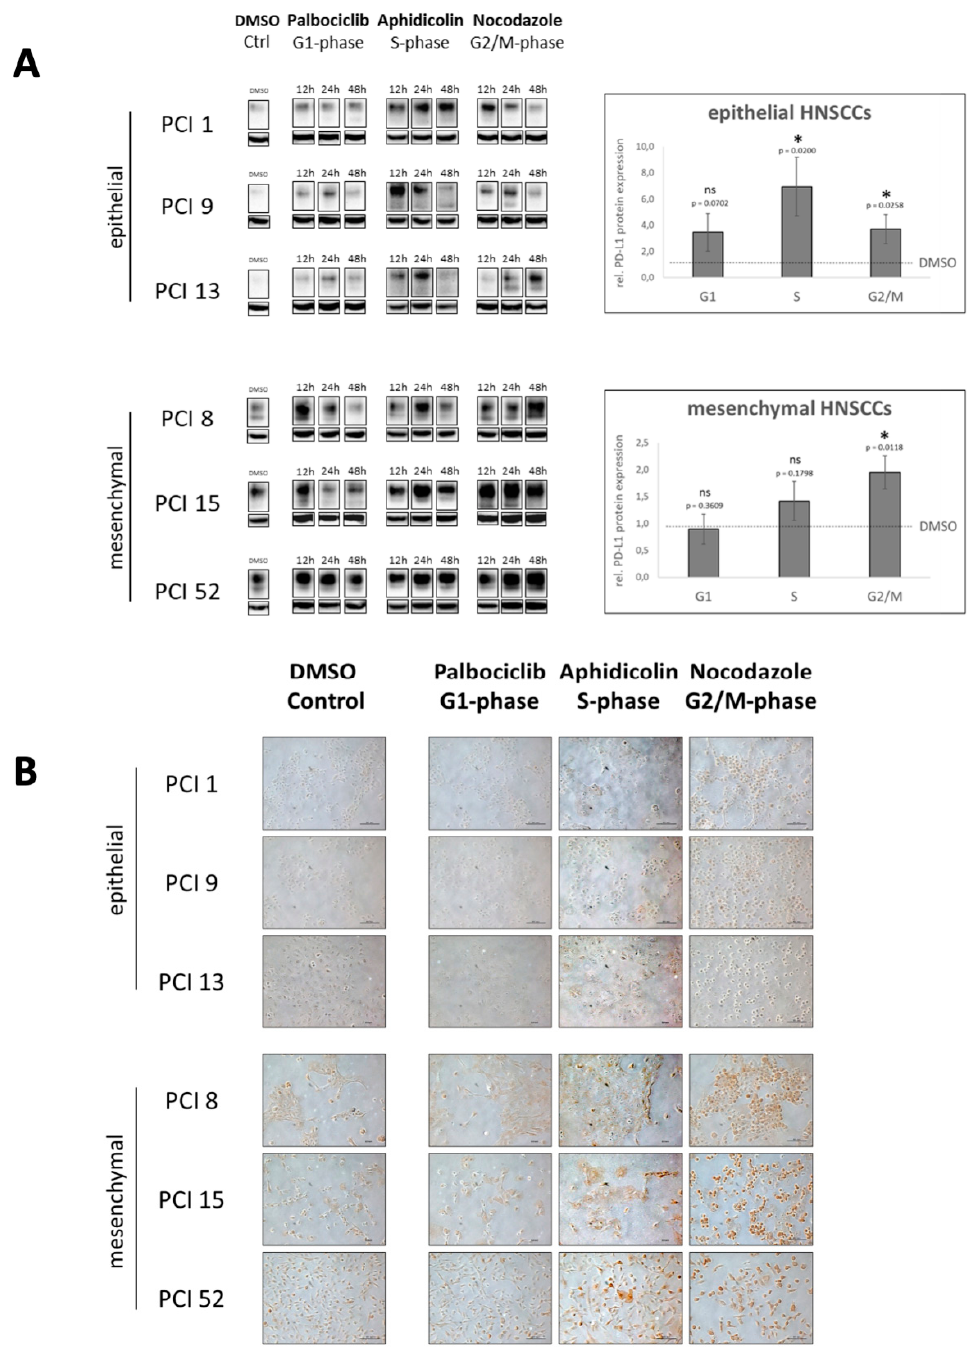
Figure 4. PD-L1 expression during cell cycle progression. HNSCC cell lines PCI 1, 9, 13, 8, 15, and 52 were specifically blocked during cell cycle phases G1, S, or G2/M. DMSO-treated controls showed PD-L1 expression of a mixed cell population of randomly distributed cells in different phases. ( A ) WB and semiquantitative analysis after inhibitor treatment in a time-dependent manner for 12, 24, and 48 h. β -actin served as a loading control. For statistical analysis, the DMSO control of the respective cell line was chosen as a reference (dashed line). The results are expressed as means ± SD (standard deviation). n = 3. Paired t -test (ns = p ≥ 0.05; * = p < 0.05). ( B ) Immunocytochemical DAB staining of PD-L1. Representative images are shown at 20-fold magnification. The scale represents 0.1 mm. Expression of PD-L1 is visible as brown staining. In Supplementary Materials Figure S2, incubation with an IgG isotype control demonstrates the specificity of PD-L1 staining. However, cells with mesenchymal characteristics (i.e., PCI 8, 15, and 52), exhibited increased PD-L1 expression or accumulation after blockade in both the S phase and